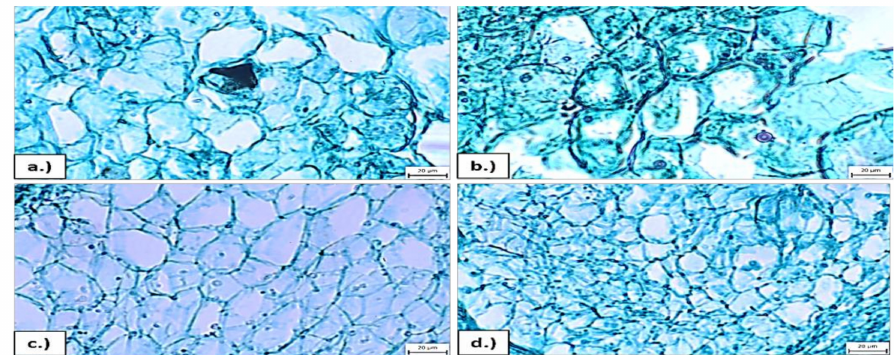
Figure 2. The e ff ect of osmotic stress induced by di ff erent polyethylene glycol (PEG) concentrations on the callus morphology in rice genotypes, including cell length, cell width, and cell wall thickness: ( a ) Choman at 0.00% PEG, ( b ) Choman at 1.50% PEG, ( c ) Gwll Swr at 0.00% PEG, and ( d ) Gwll Swr at 1.50%